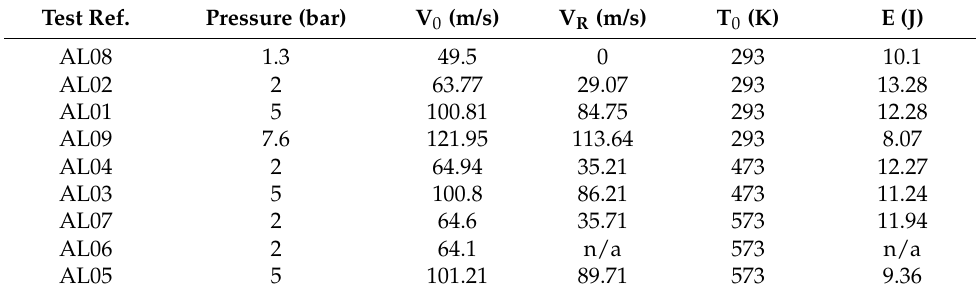
Table 2. Summary of the perforation tests.